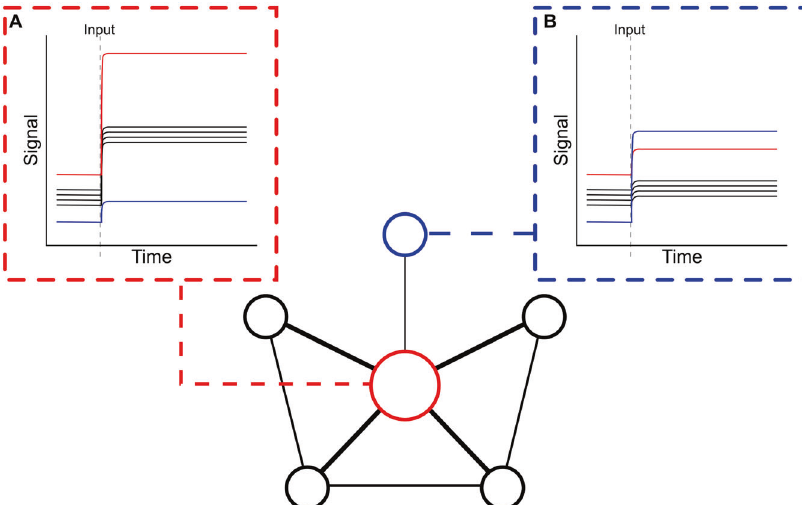
Fig. 1 A conceptual illustration of network control theory (NCT). The central network represents a dynamical system of six nodes, with edge thickness representing the strength of each connection. A Shows the effect on the output signal of the entire system when an input is made to the red node. This input leads to the largest increase in the signal of the red node, a moderately large increase in the signal of the 4 black nodes, and a small increase in the signal of the blue node. This is indicative of the red node having high average controllability, as overall the system responds strongly to input to the red node. B Shows the effect on the entire system when an input is made to the blue node. This input leads to a large increase in the signal of the blue node and only small increases in the signal of the red and black nodes. This is indicative of the blue node having high modal controllability, as the blue node itself is dif fi cult to reach via other nodes. The blue node also has low average controllability, as input to the blue node does not impact the rest of the system